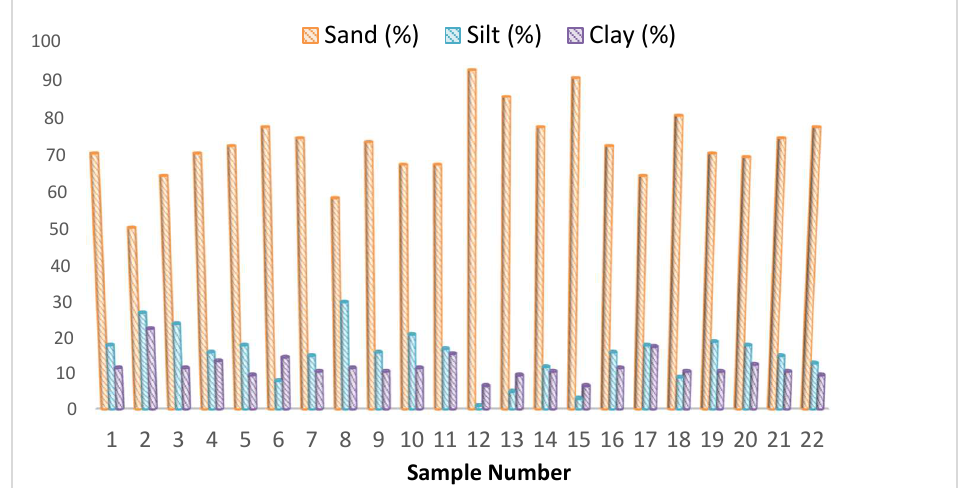
Figure 8. The distribution of soil content within different soil samples analyzed in Koromi catchment of Jos East LGA.